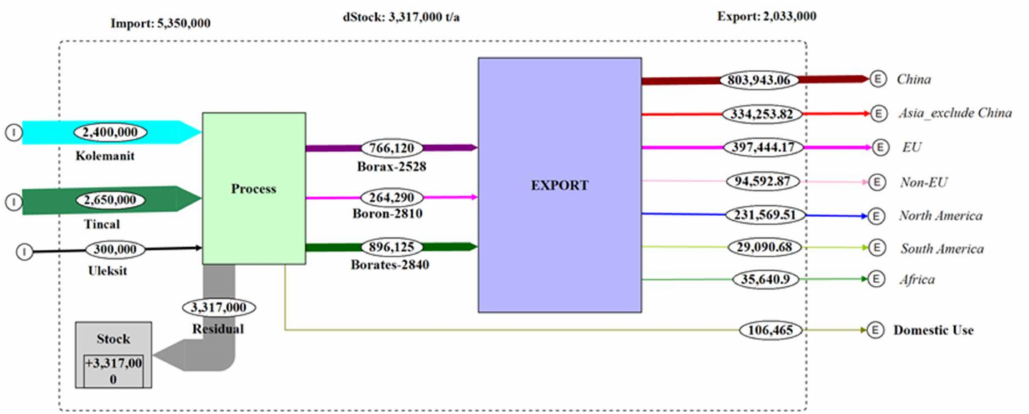
Figure 11. MFA of boron from Turkey to the